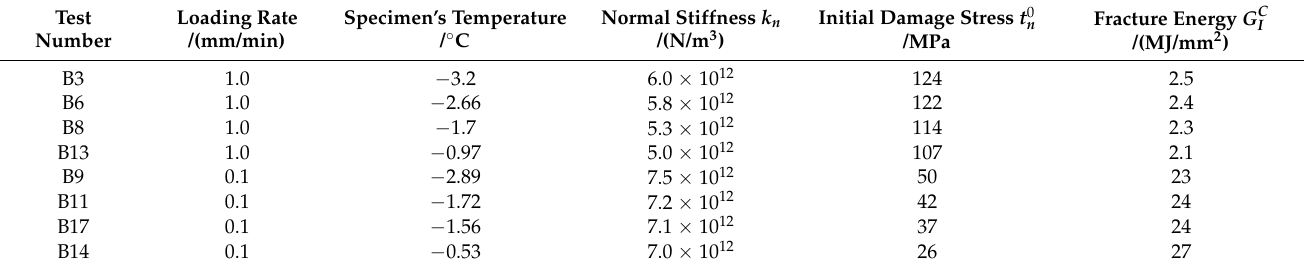
Table 1. The CZM parameters used in the numerical simulation.